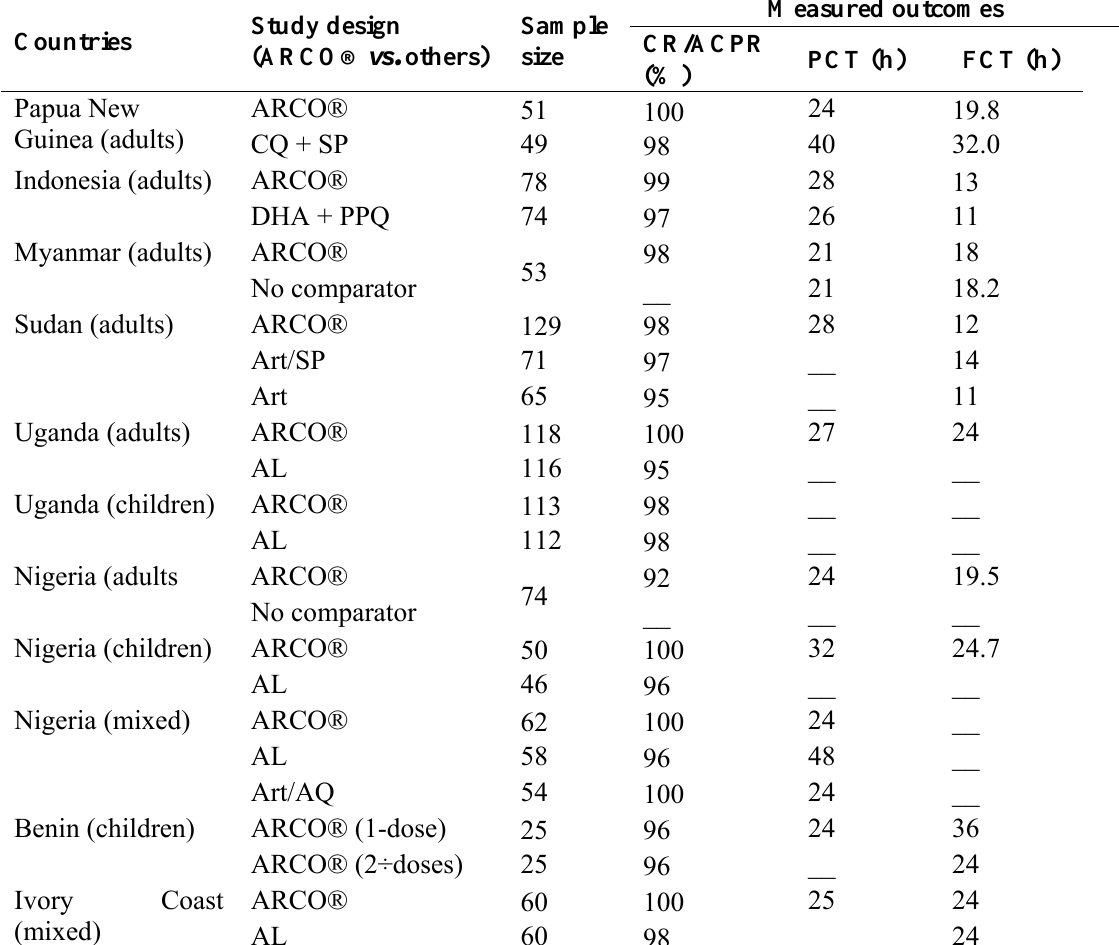
Table 1. Summary data of different studies in different countries (CR = cure rates; ACPR = adequate clinical and parasitological response; PCT = parasite clearance time; FCT = fever clearance